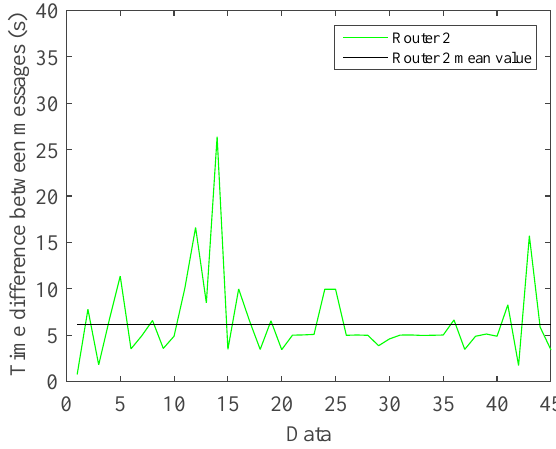
Figure 16. Case A.2: Time intervals between the data points received.